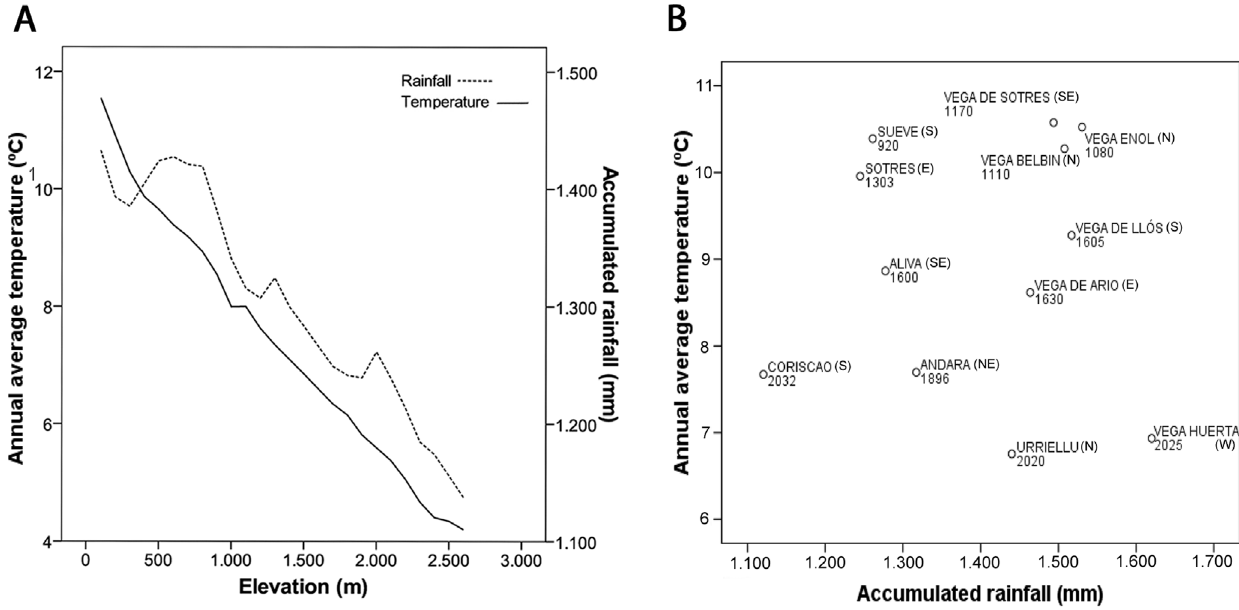
Figure 2. Climate of the Study area and localities. (A) Graphical representation of the average annual temperature ( u C; solid line) and accumulated rainfall (millimeters/year; dotted line) along the elevational gradient in our study area. (B) Annual average temperature and annual accumulated rainfall of each sampling locality, and the associated elevation (m.a.s.l.). The slope exposition is also shown (N = North, S = South, E = East, W =